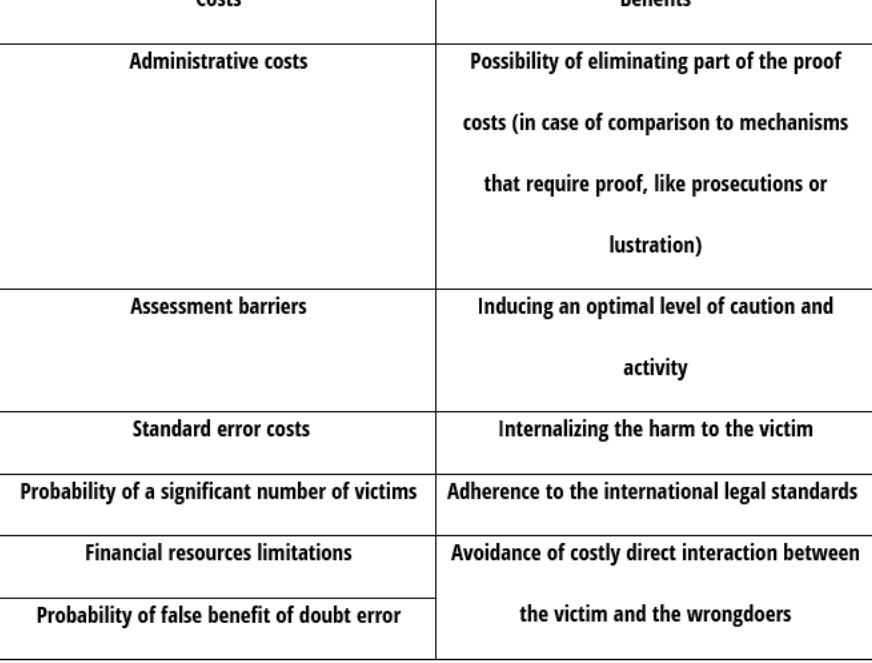
Figure 3: Table (3) Cost-Benefit Matrix of Reparations as a T.J.